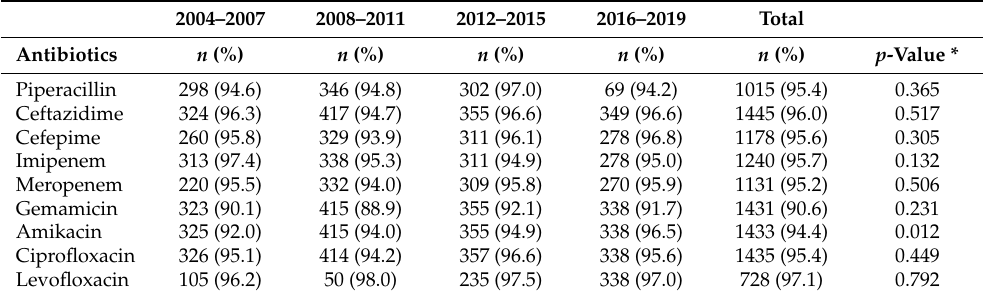
Table 4. Summary of in vitro antibiotic susceptibility of gram-negative isolates between 2004–2007,